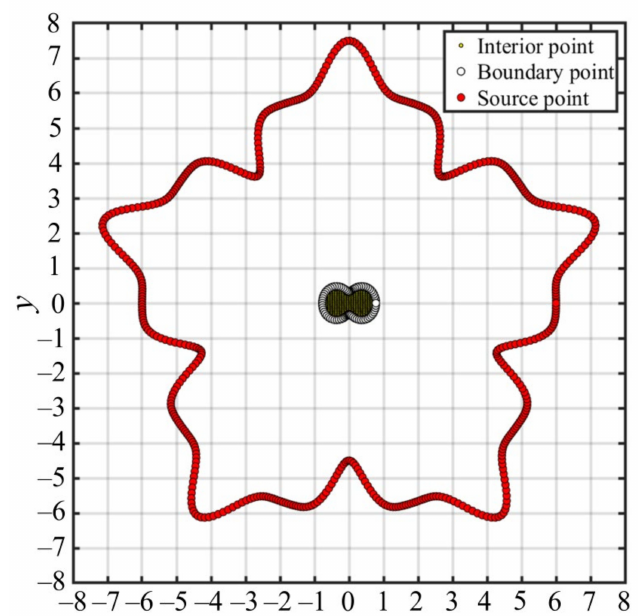
Figure 14. The fictitious